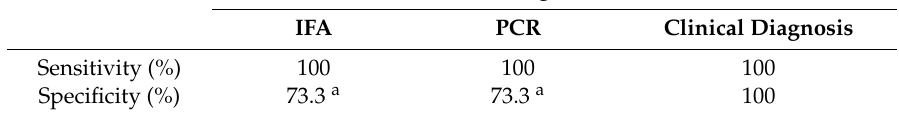
Table 4. Comparison of sensitivity and specificity of traD qPCR using IFA, PCR or results of clinical diagnosis